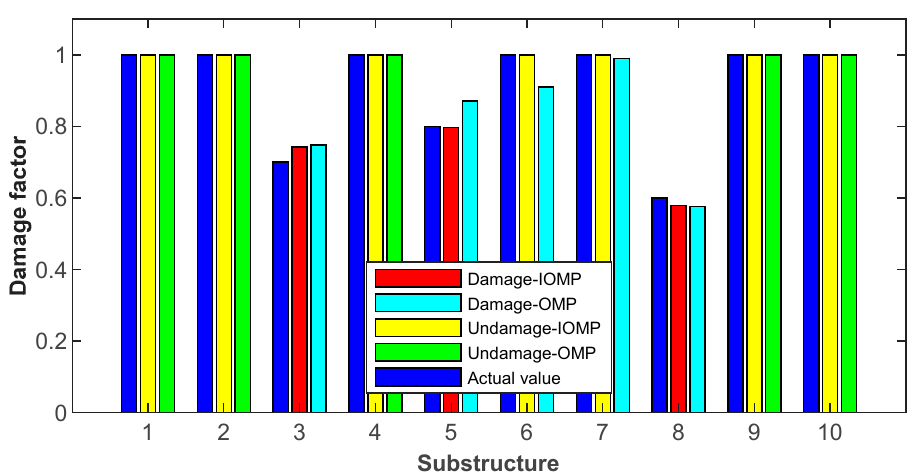
Figure 6. Identification results obtained using OMP and IOMP method (sensitivity correlation criterion).